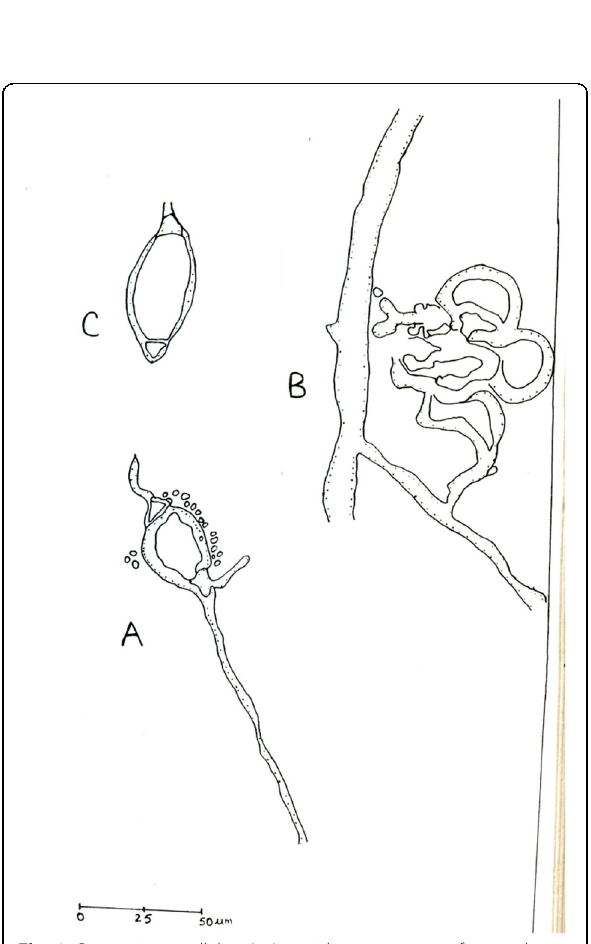
Fig. 3 Catenaria anguillulae . A. A conidium on agar surface under germination. B. A portion of hypha with adhesive network. C. Detached conidium